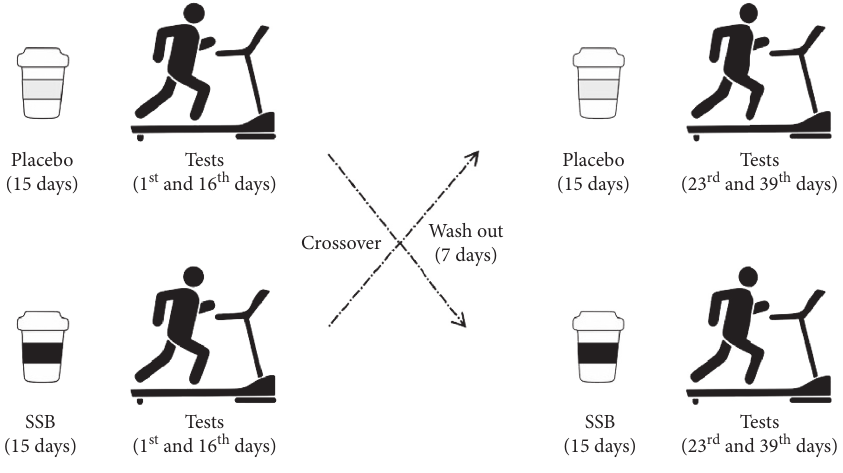
Figure 1: Experimental